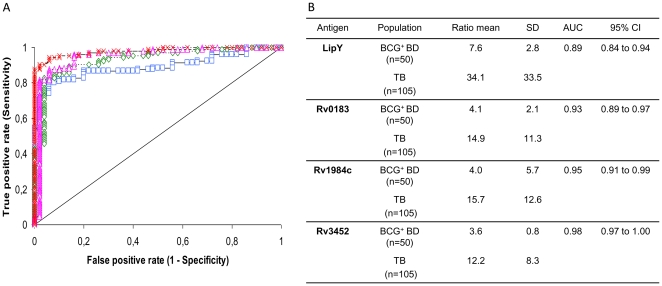
ROC analysis of the antibody response against four M. tuberculosis lipolytic enzymes.(A) Comparison of the ROC curves for IgG detection specific to LipY (blue), Rv0183 (pink), Rv1984c (green) and Rv3452 (red). The grey line represents the no-discrimination line from the left bottom to the top right corners. (B) Ratio mean, standard deviation (SD) and area under the ROC curve (AUC) derived from (A). The p value for active TB patients versus healthy controls (BCG+ BD) is <0.0001. BCG+ BD, BCG vaccinated blood donors; n, number of sera; CI, confidence interval; SD, standard deviation.